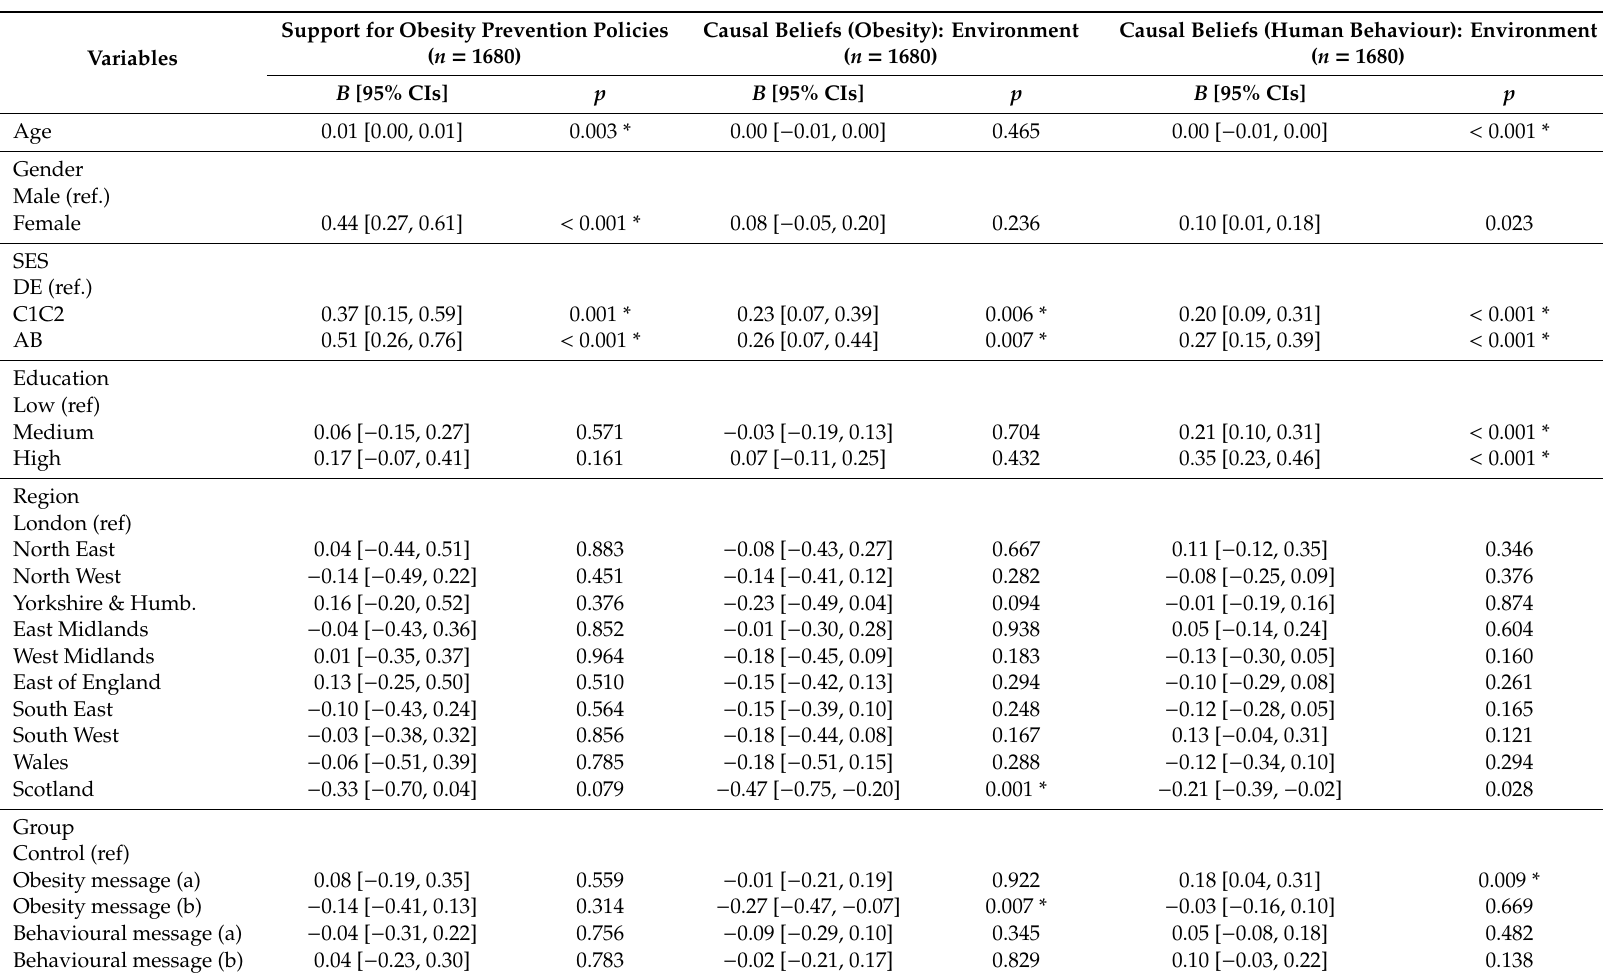
Table 1. Main e ff ects of intervention messages on support for obesity prevention policies and beliefs about causes of obesity and human behaviour (Study 1). Support for Obesity Prevention Policies Causal Beliefs (Obesity): Environment Causal Beliefs (Human Behaviour): Environment ( n = 1680) ( n = 1680) ( n = Variables